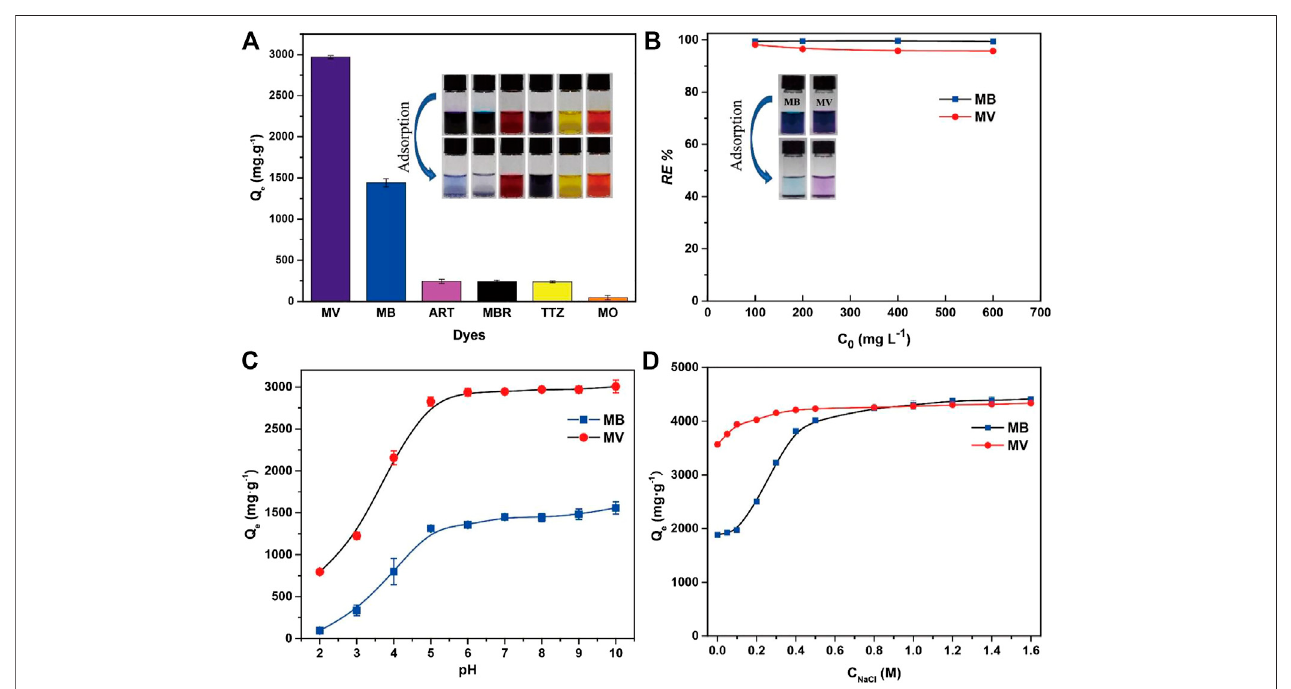
FIGURE 3 | (A) Adsorption capacity of PFPCS for different dyes. Insets: photographs of different dyes (1,000 mg L − 1 ) before (above) and after (below) adsorption byPFPCS. (B) Theeffectofinitialdyeconcentrationontheremovalef fi ciencyofPFPCStowardsmethylviolet(MV)andmethyleneblue(MB)dyes.Insets:photographsof MB and MV solutions (100 mg L − 1 ) before (left) and after (right) adsorption by PFPCS. (C) The adsorption performance of PFPCS for MV and MB at different pH. (D) Effect of ionic strength on the adsorption of MB and MV by PFPCS at pH (cid:2) 8 and 25 °